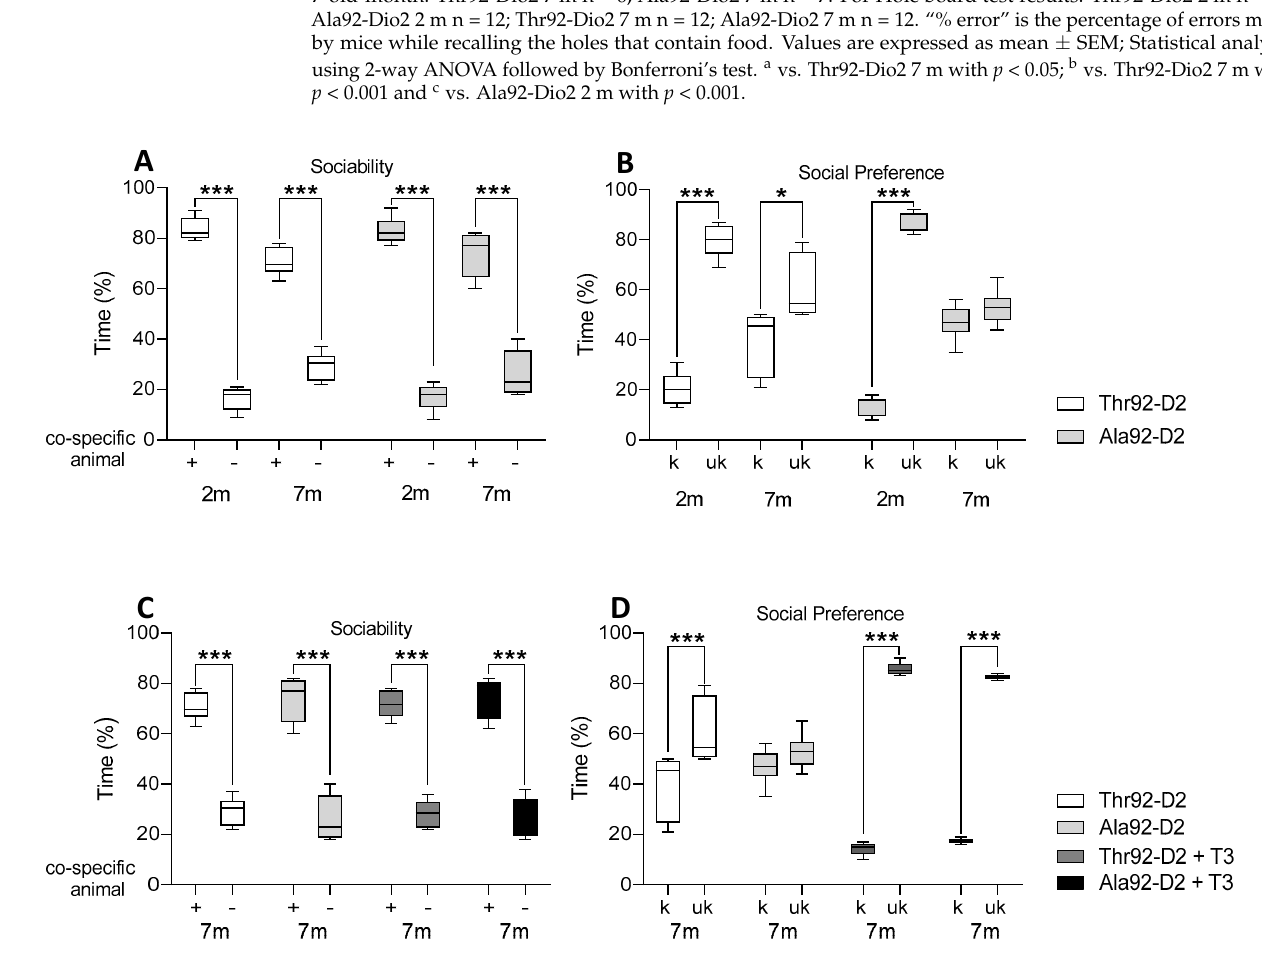
Figure 1. Cognitive tests in 2–3 (2 m) and 7–8-month-old (7 m) male mice. The social recognition test are displayed as time (% of total time) to assess sociability ( A , C ) and social preference ( B , D ) for Thr92-Dio2 and Ala92-Dio2 mice and mice treated with T3 for ten days; in each plot, “+” represents a co-specific animal and “ − “ represents an empty cage and k represents a familiar mouse and uk represents an unknown mouse; n = 6–7/group. * p < 0.05 and *** p < 0.001 as calculated through the two-way ANOVA followed by the Bonferroni post-test. These experiments were repeated once with similar results; only one set of results is shown in the